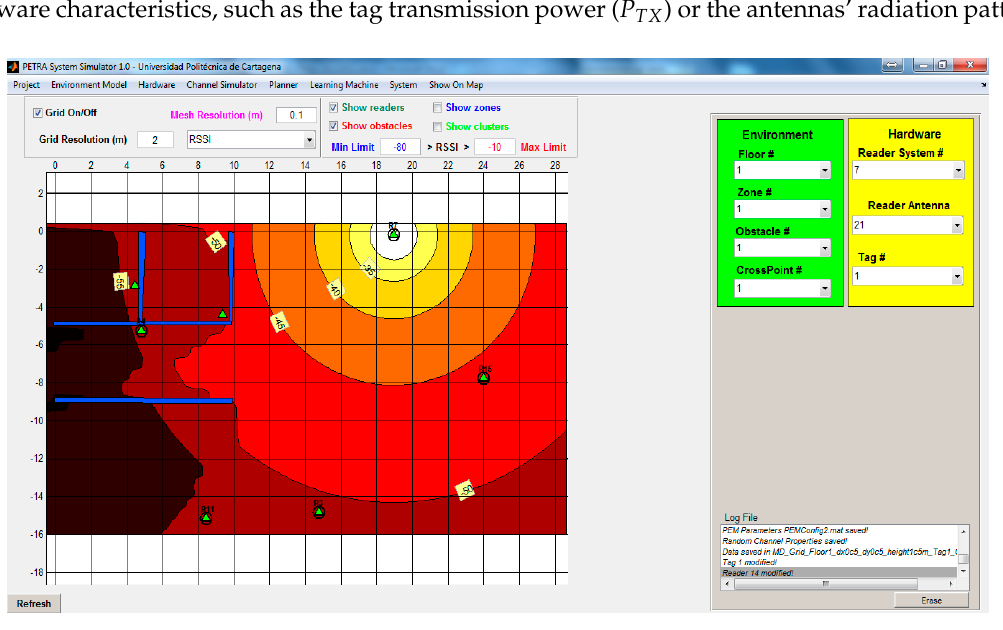
Figure 7. Interface of the ILS simulator.